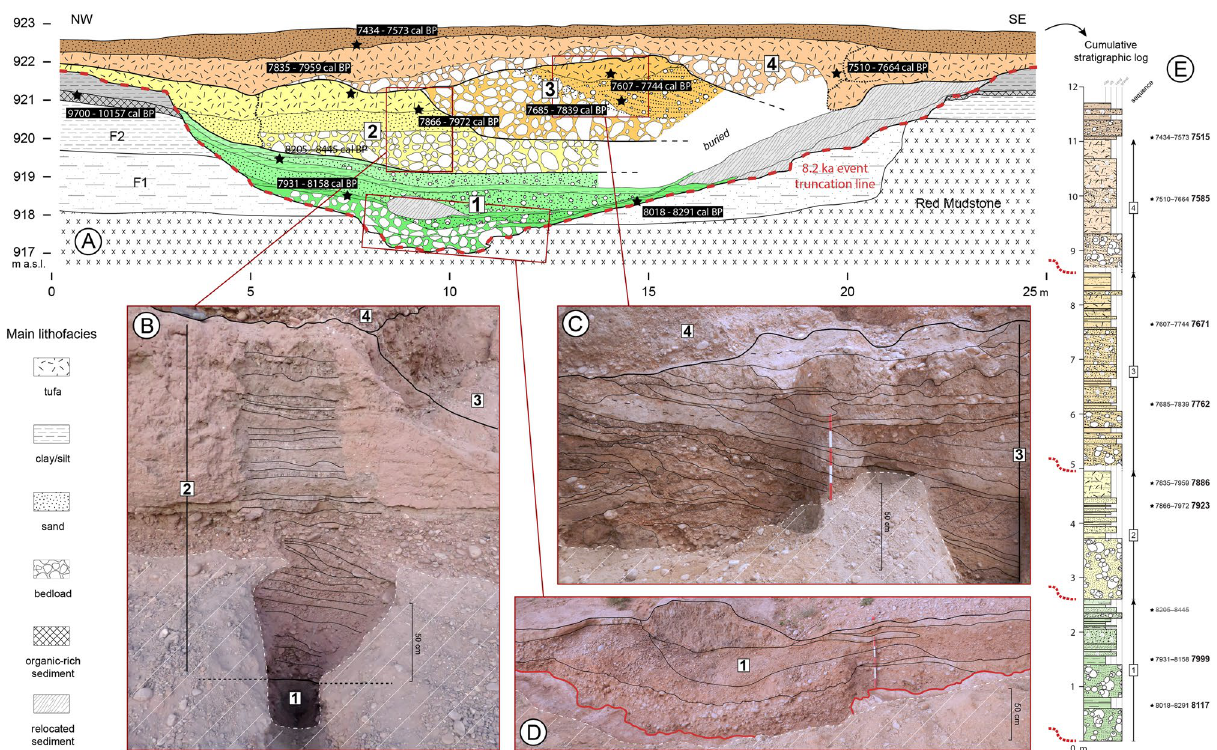
Figure 3. ( A ) Transverse section across the Cha07 palaeochannel infilling showing the main litho-stratigraphic units, positions of radiocarbon datings (2σ cal. BP), and underlying formations: Early Holocene F2, pre- Holocene F1, and Red Mudstone formation. ( B – D ) Detailed views of parts of the palaeochannel infilling with stratigraphic units. ( E ) Cumulative stratigraphic log with litho-sedimentary units grouped into fluvial sequences. Data source and software: drawing by B. Depreux using Adode Illustrator CC (https:// www. adobe. com/), and pictures from B. Depreux and J.-F.